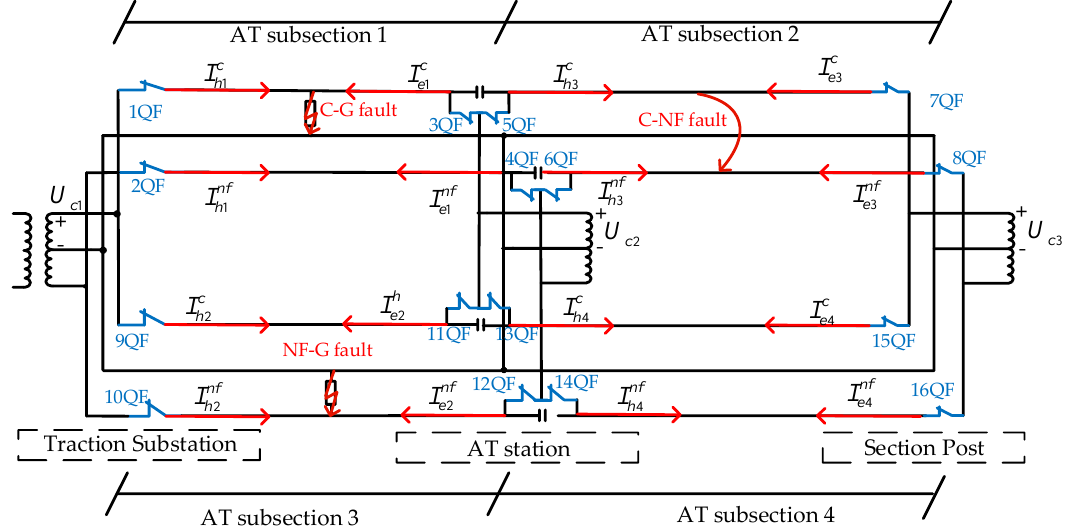
Figure 11. Simplified diagram of information collection and fault locations in the novel segmental all parallel AT TPSS.